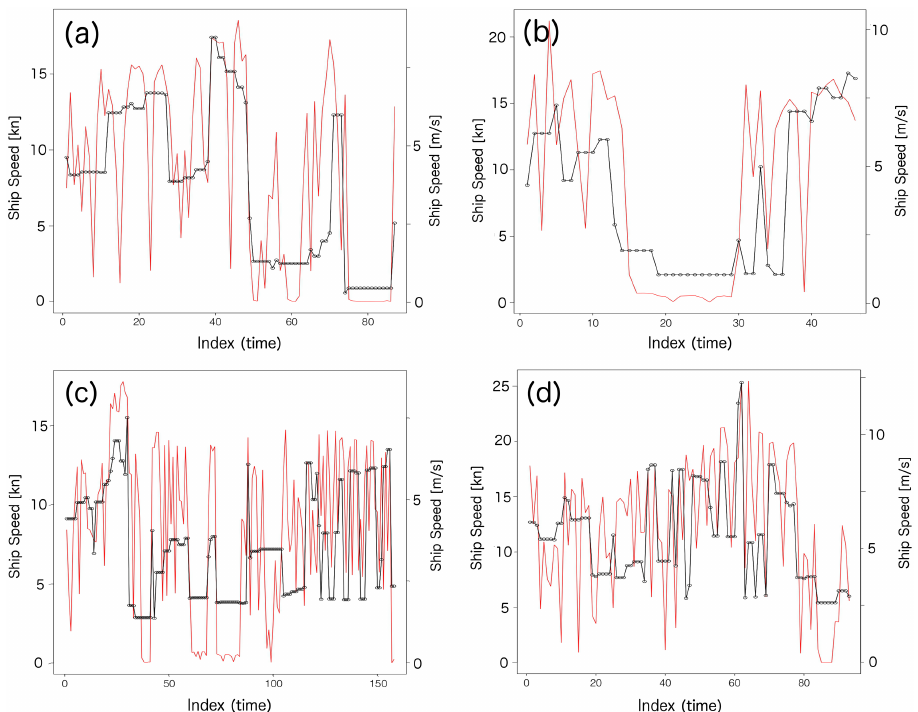
Figure 7. (a) – (d) Observed (red lines) and reconstructed (black lines) ship speeds for typical vessels in the test region: (a) general cargo, 120m; (b) oil tanker, 140m; (c) cargo, 117m; (d) Ro-Ro, 166m. The reconstructions are based on a multilinear regression of forecasted ice concentration, level ice thickness, ridge density, ice speed and an additional factor which is based, inter alia, on the angle at which the ship is moving relative to the ice movement (parameterized as described in Fig.